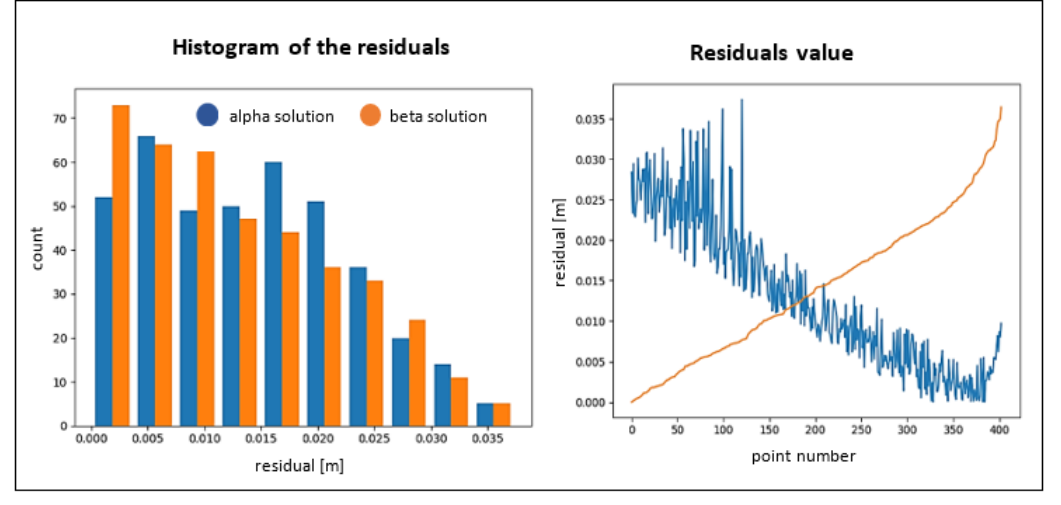
Figure 13. Concrete slabs of a retaining wall.